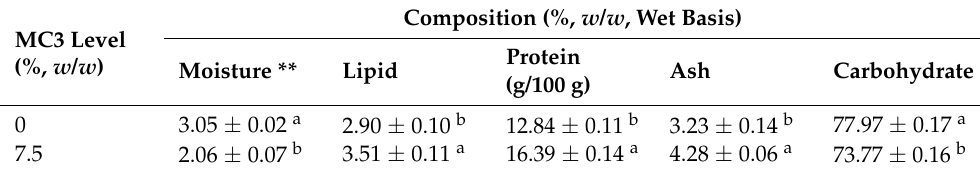
Table 5. Chemical composition of whole wheat cracker and that fortified with 7.5%